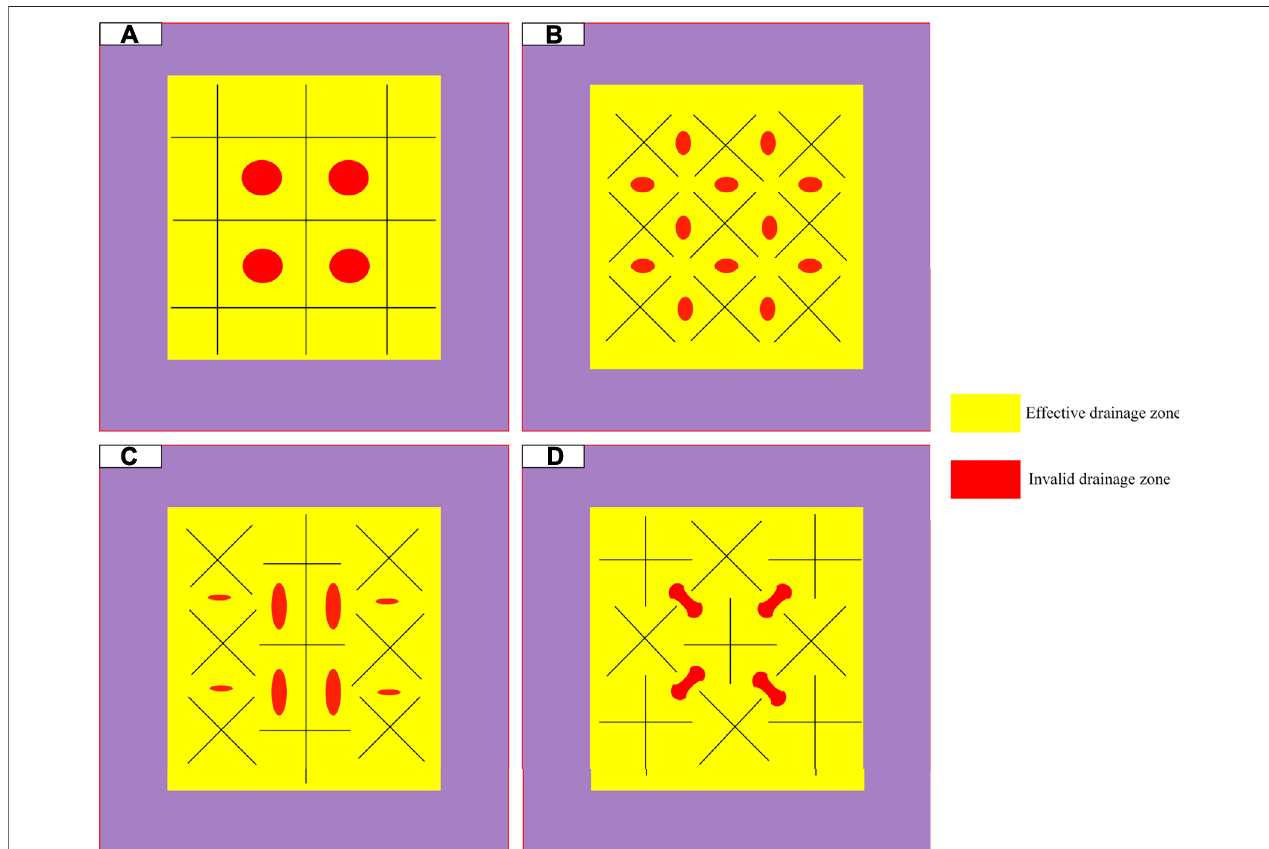
FIGURE5| Sketchesshowingtree-typesub-boreholes during coalminemethanedrainage.Zones wherethemethanehasnotyetbeendrainedareshown inred. The sub-borehole layouts shown are: (A) Square layout; (B) Rhombic layout; (C) Parallel mixed layout; (D) Cross mixed layout.